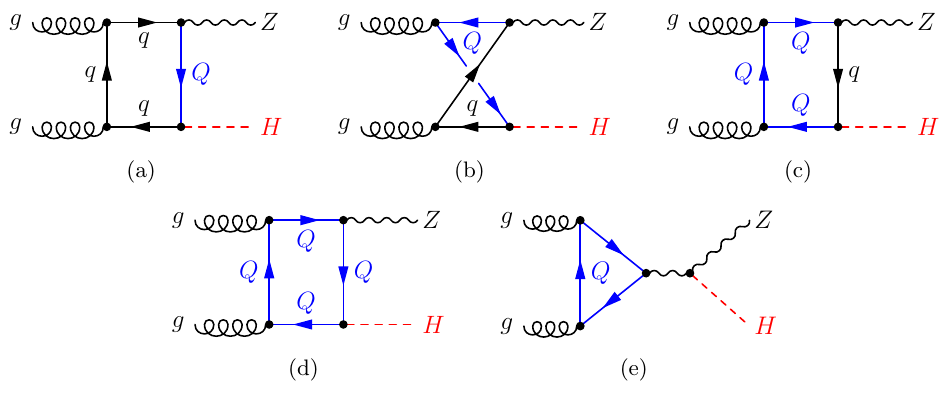
Figure 10 . New contributions to the gg ! ZH amplitude due to VLQ s. Here, Q 2 f B; T g , and q is the SM quark which mixes with Q